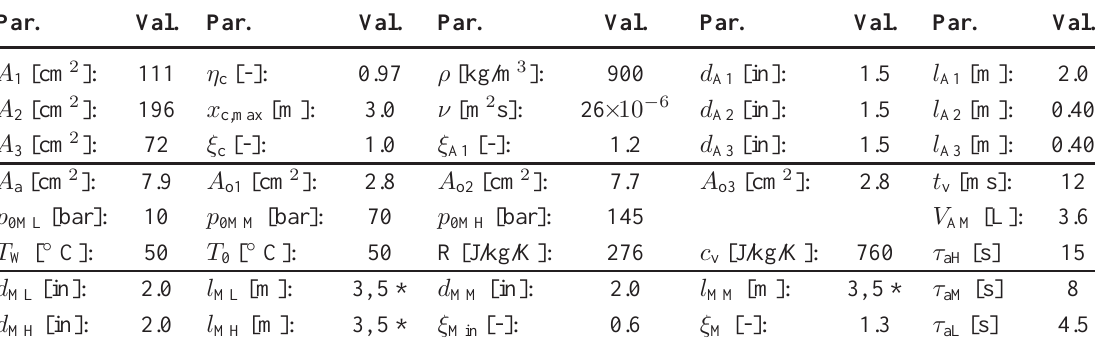
Table 2. Values used for the float module, where “Par.” and “Val.” abbreviate parameter and value, respectively. * hose connection length is 3 m for float 1–10 and 5 m for float 11–20. Par. Val. Par. Val. Par. Val. Par. Val.